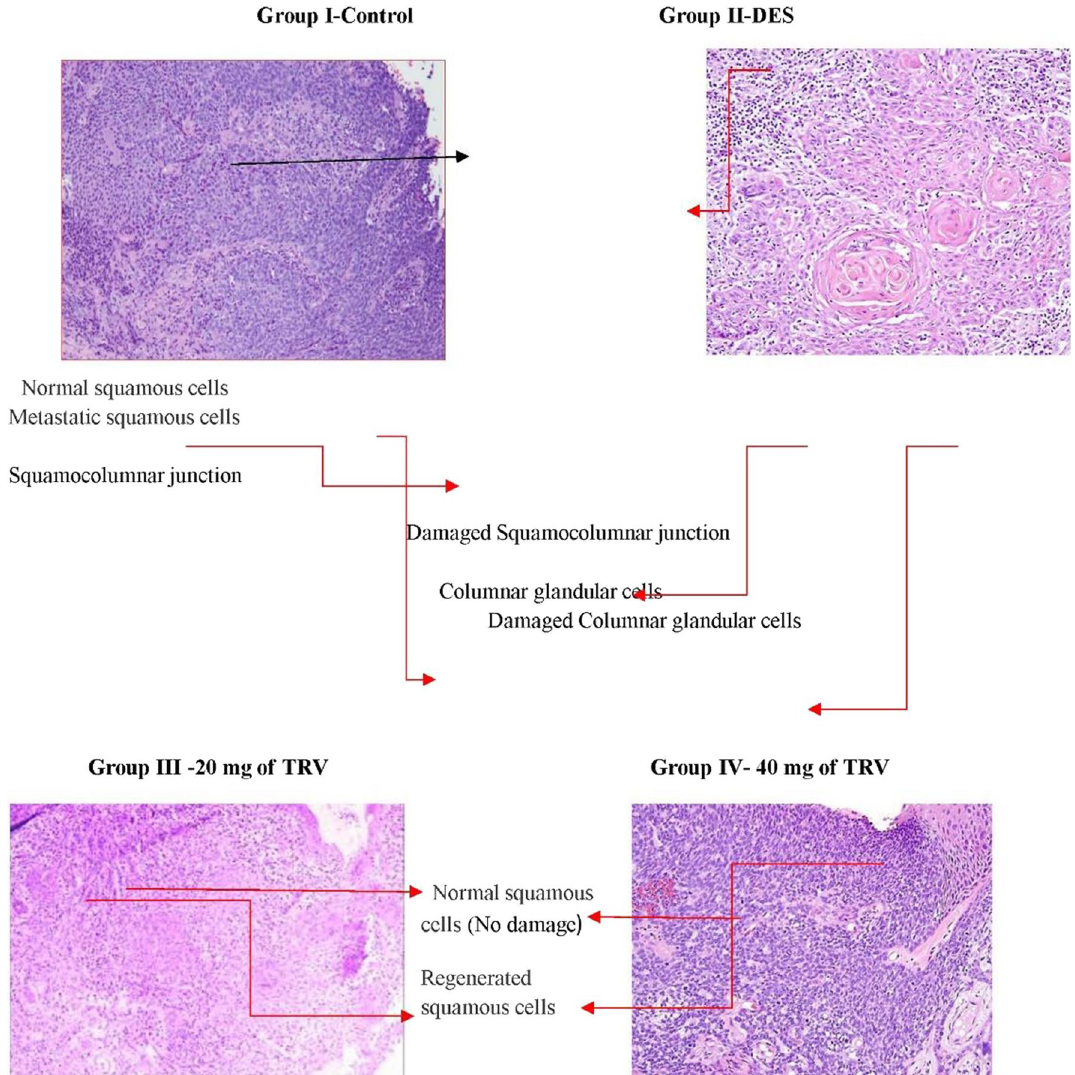
200). B Pelvic lymph ×